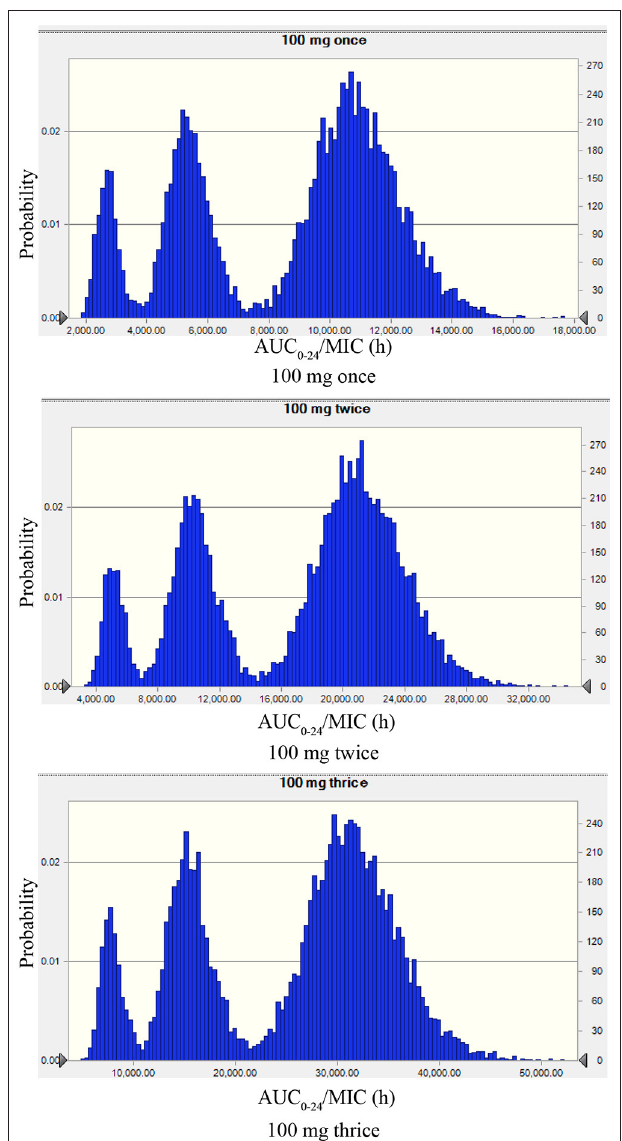
FIGURE 5 | The probability distribution plots of AUC/MIC analyzed by Monte Carlo simulation mimicking rifaximin dosing regimens of 100 mg/gland by intramammary infusion once, twice, and three times. The peak on the left, the middle, and the right represents the AUC/MIC plotted distribution of the highest MIC (0.125 µ g/ml), the median MIC (0.063 µ g/ml), and the lowest MIC (0.031 µ